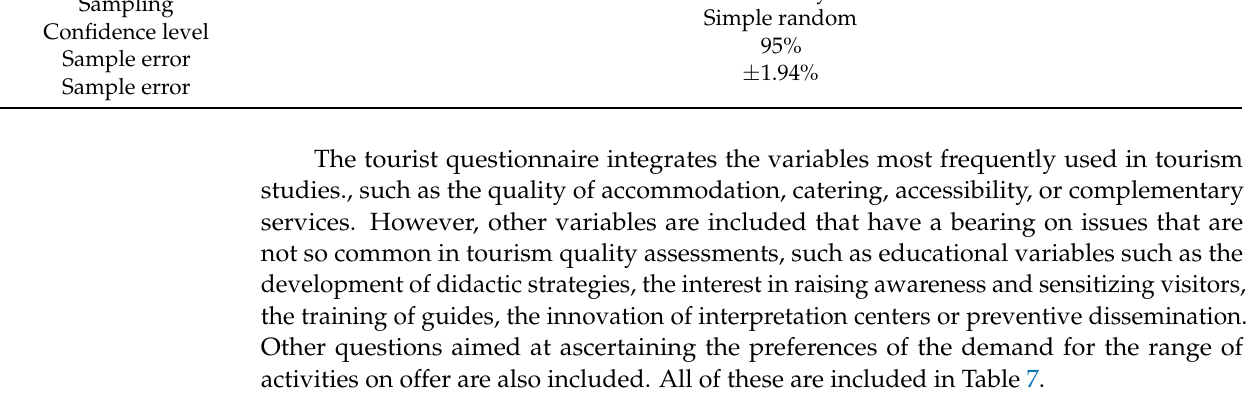
Table 7. Analysis variables in the second survey of